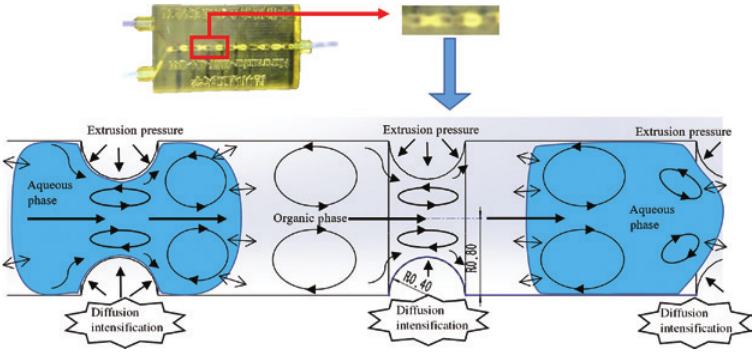
Figure 2: Schematic diagram of internal flow pattern in the microchannel of the “Y”